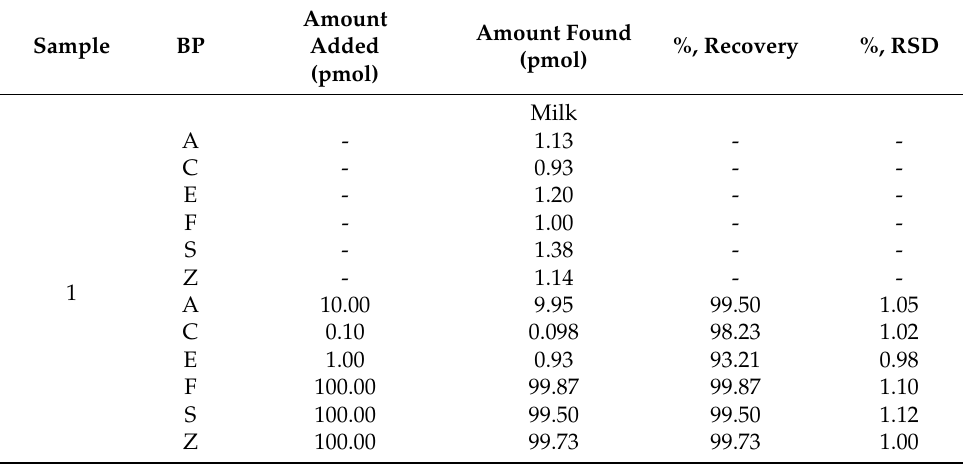
Table 2. The determination of bisphenols from different food